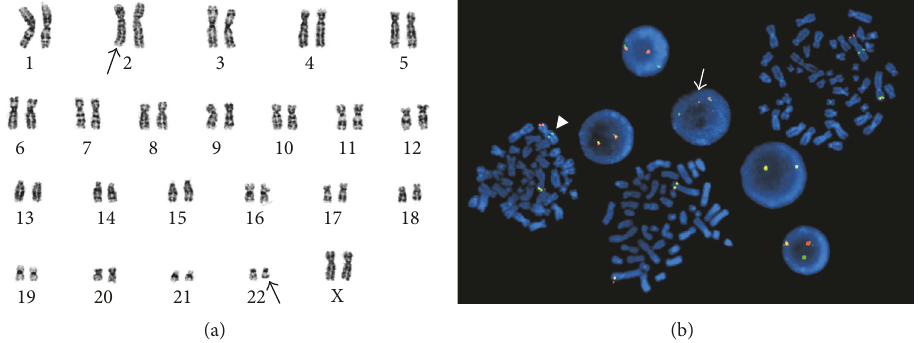
Figure 7: Cytogenetic analysis of bone marrow. (a) The G-banded metaphase cell demonstrates abnormalities involving chromosomes 2 and 22 (black arrows), interpreted to represent an initial chromosome 2 pericentric inversion that disrupts the ALK gene at band 2p23 and translocates the centromeric portion of the gene to band 2q22. This is followed by a translocation between the inverted chromosome 2 (with a breakpoint distal to the ALK gene) and chromosome 22q. The karyotype is designated as 46,XX,inv(2)(p23q22)t[inv(2);22)(p24;q12)]. (b) Fluorescence in situ hybridization (FISH) utilizing an ALK gene break-apart probe demonstrates disruption of the gene (white arrow) and relocation of the centromeric portion of the gene to the long arm of chromosome 2 (white arrow head) as a result of the chromosome 2 pericentric